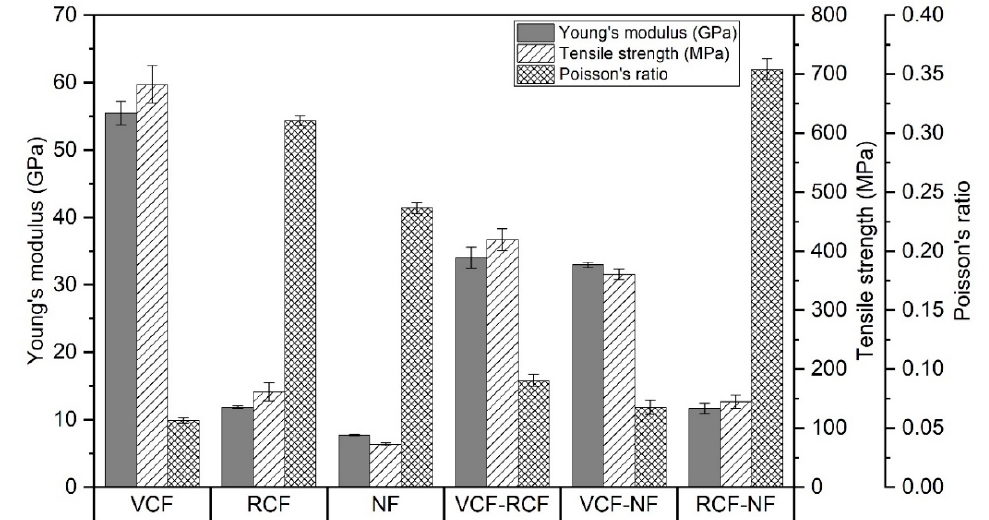
Figure 9. Young’s modulus, tensile strength and Poisson’s ratio results for the pure and hybrid